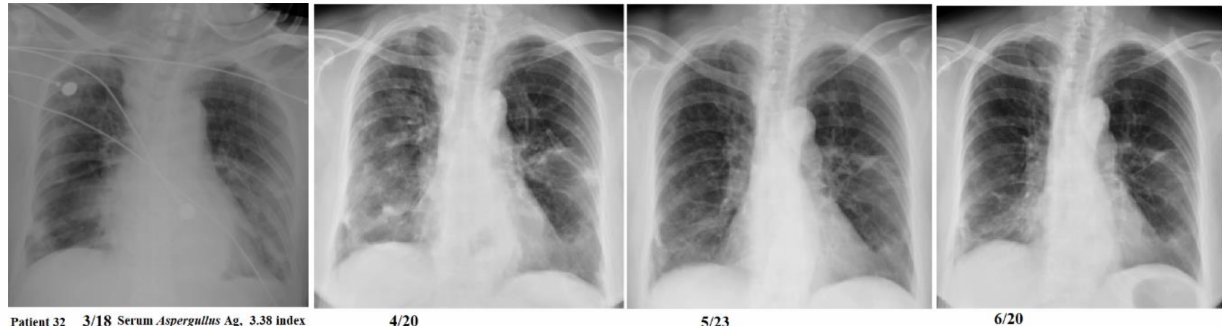
Figure 3. A 64-year-old woman had a serum Aspergillus galactomannan test of 3.38 index and did not receive any antifungal therapy but experienced a prolonged course of more than 3 months for resolution of the bilateral pulmonary